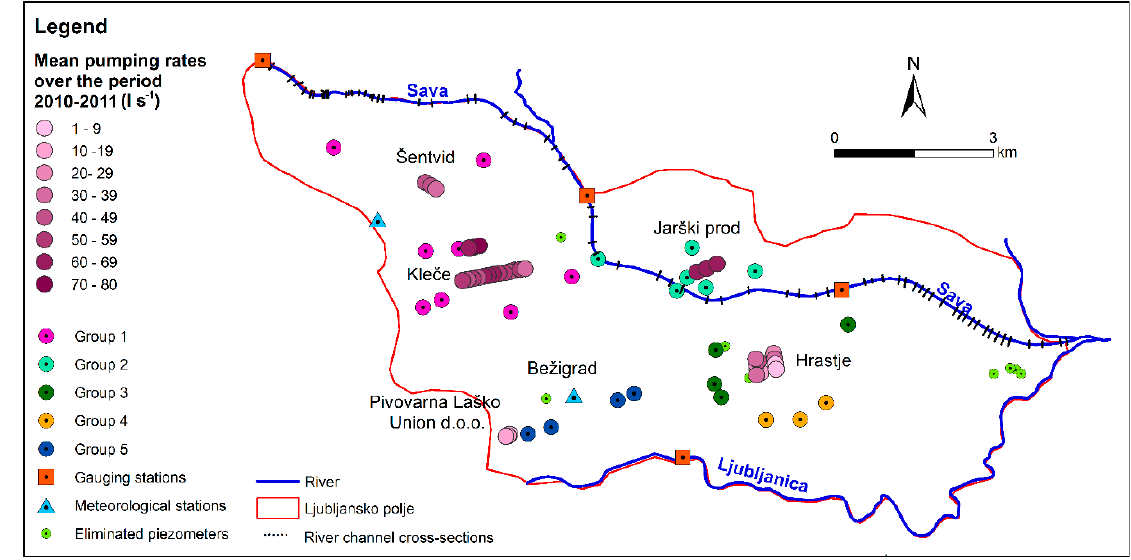
Figure 2. Locations of pumping stations and wells with mean pumping rates in L s − 1 for 2010–2011. Locations of piezometers (five groups), three meteorological stations, and three gauging stations on the Sava River and one on the Ljubljanica River. The Sava River cross-sections used in MIKE 11.